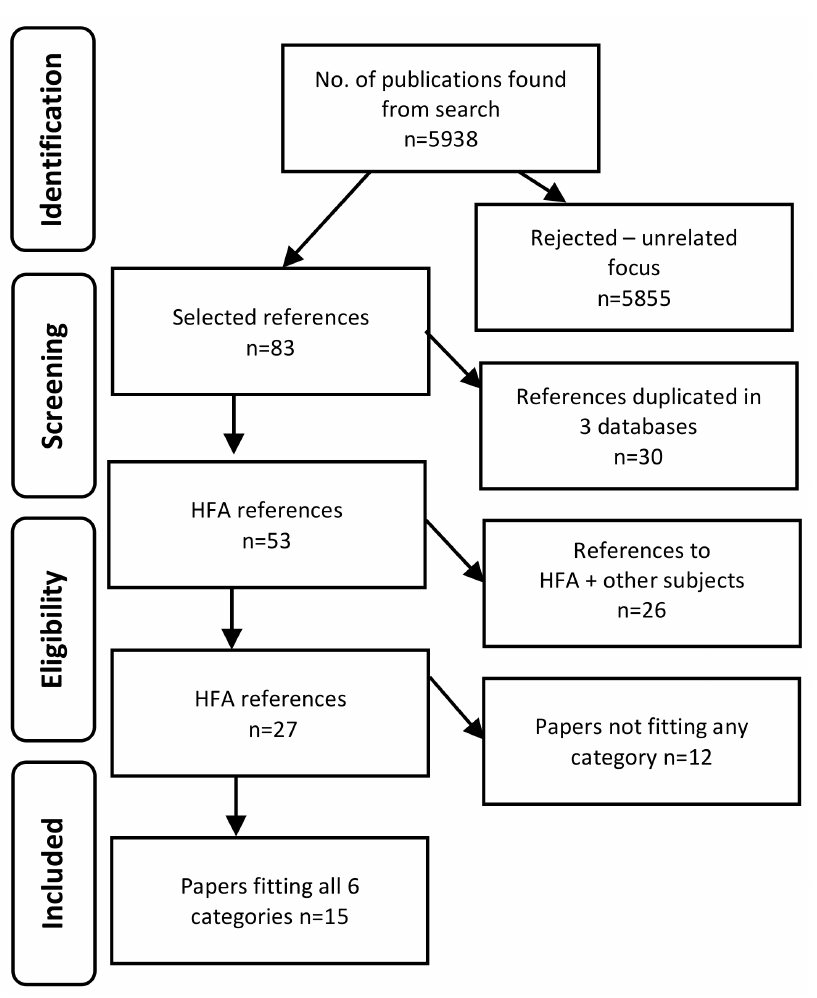
Figure 1. Flow chart of items used for the narrative